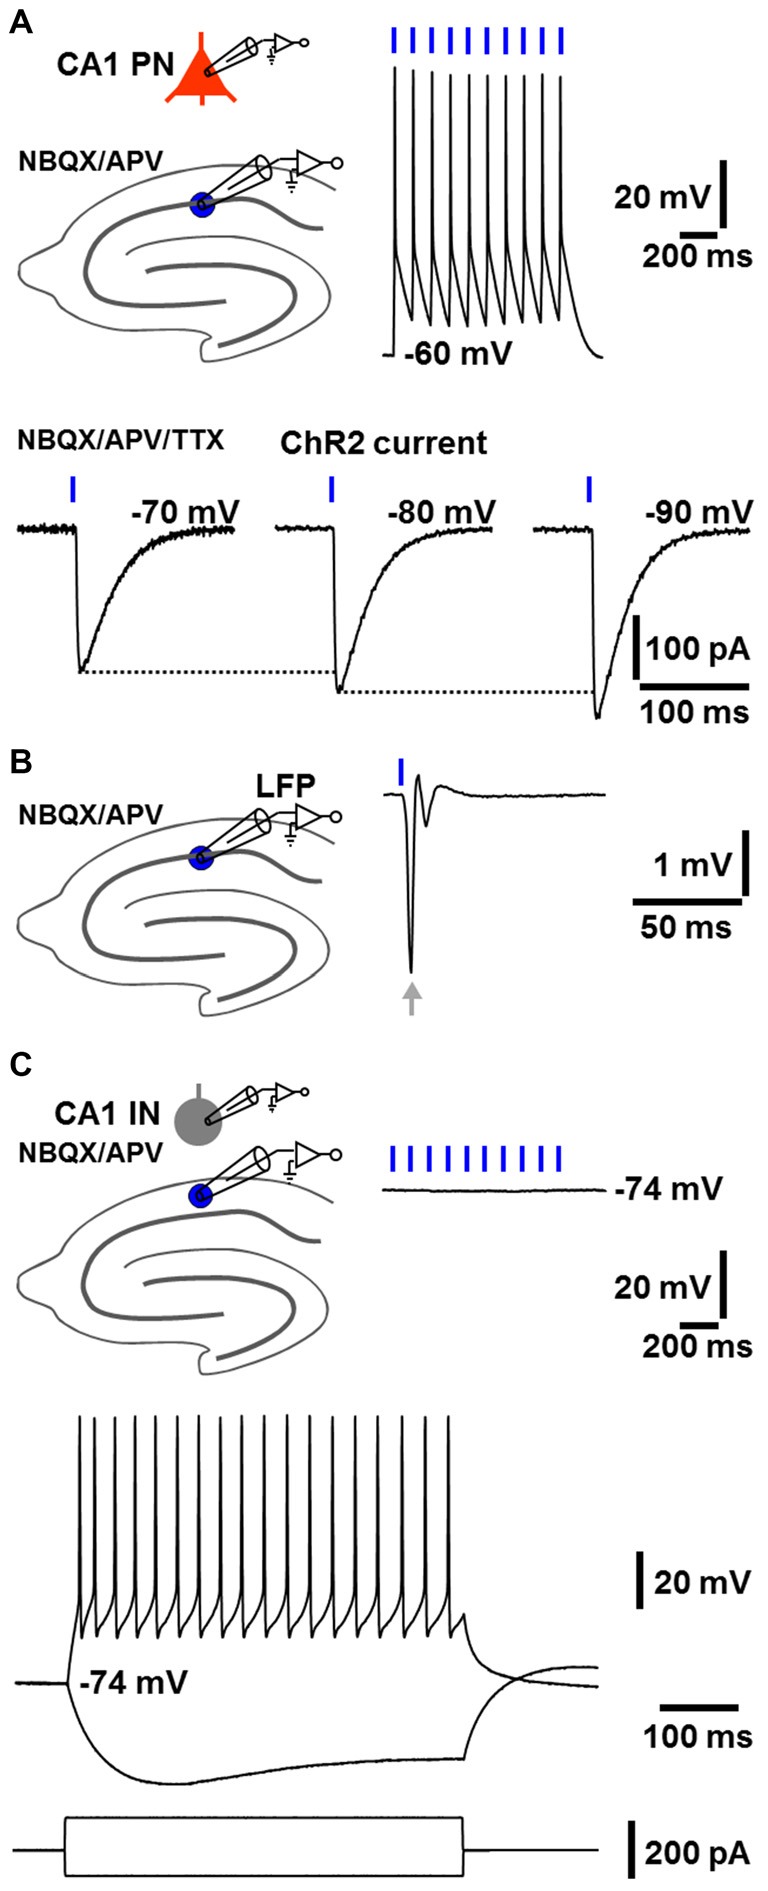
NEX-Cre-Channelrhodopsin-2 (ChR2) mice express functional ChR2 selectively in glutamatergic cells. (A) As measured by whole-cell patch-clamp recordings under blockade of ionotropic glutamate receptors by 2,3-dihydroxy-6-nitro-7-sulfamoyl-benzo[f]quinoxaline-2,3-dione (NBQX) and (2R)-amino-5-phosphonovaleric acid (APV), CA1 pyramidal neurons (CA1 PNs) reliably fired action potentials in response to blue light pulses (2 ms). Consequently, ChR2 currents, which increased with more negative membrane potentials, could be detected in CA1 PNs (extracellular solution additionally contained the sodium channel blocker tetrodotoxin, TTX). (B) As revealed by local field potential (LFP) recordings in the CA1 stratum pyramidale, a single light pulse invariably triggered a prominent population spike generated by CA1 PNs (arrow, extracellular solution contained NBQX and APV). (C) CA1 stratum oriens interneurons (CA1 INs), which exhibited firing characteristics of fast-spiking interneurons upon positive current injection, showed no membrane potential deflections in response to blue light pulses (extracellular solution contained NBQX and APV).